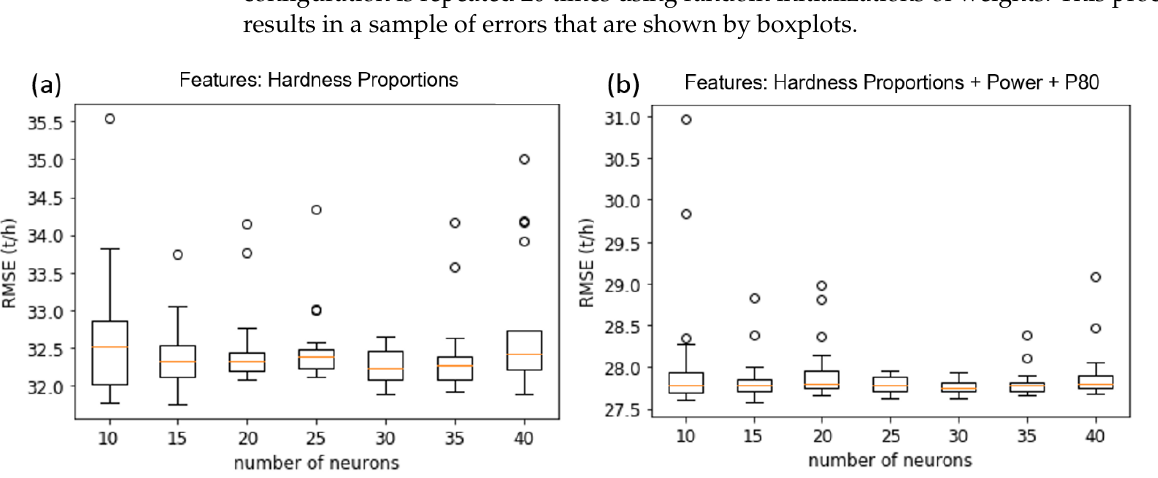
Figure 3. Comparison of the number of neurons for two selected feature sets: ( a ) hardness proportions and ( b ) hardness proportions, ball mill power and product particle size (P80).